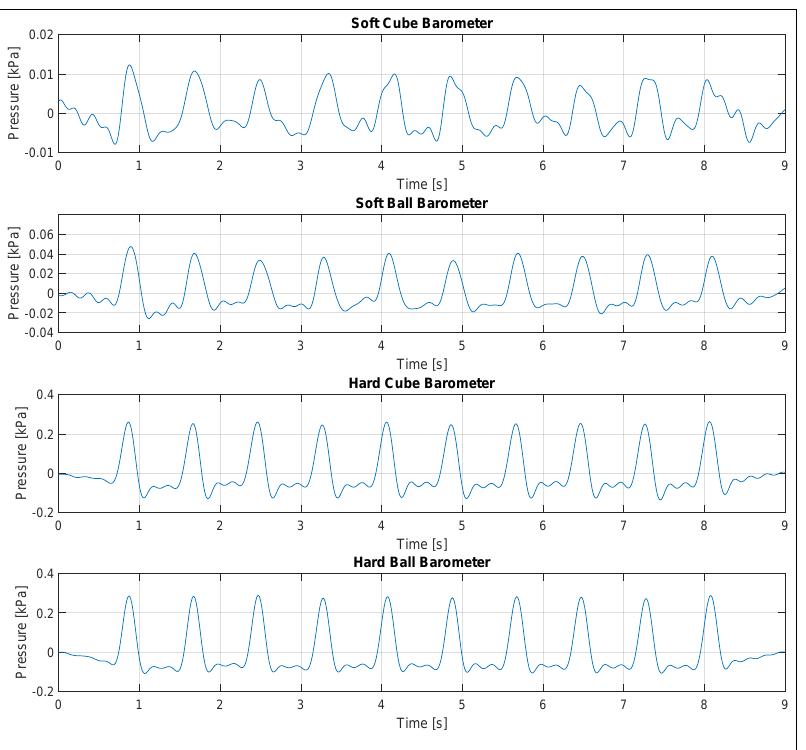
Figure 9. Filtered barometric